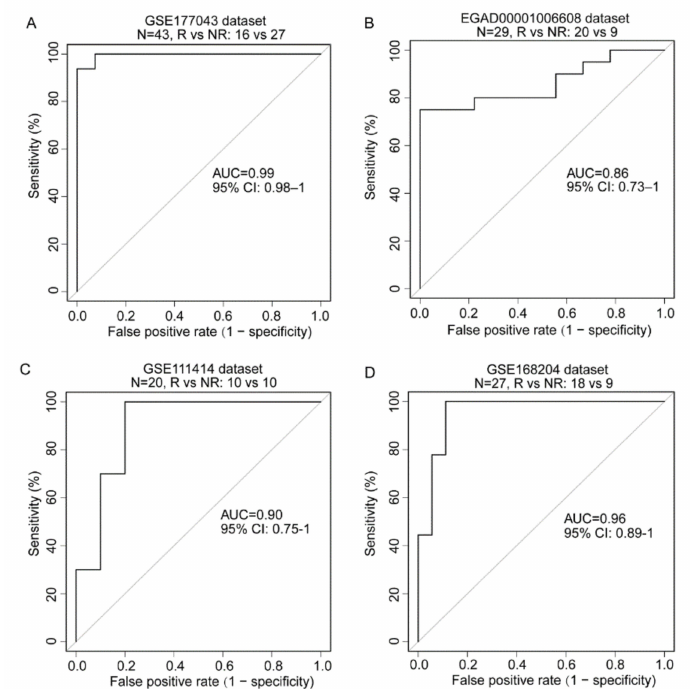
Figure 6. Prediction of ICT outcomes by RTM.Sig. ( A ) The RTM.Sig accurately predicted ICT outcomes of BC patients in initial discovery dataset (accession number: GSE177043). The RTM.Sig had an AUC value of 0.99 (95% CI: 0.98–1). ( B ) The predictive performance of RTM.Sig in the